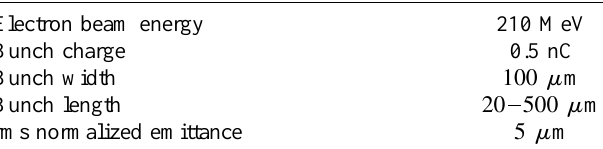
TABLE I. Electron beam parameters.